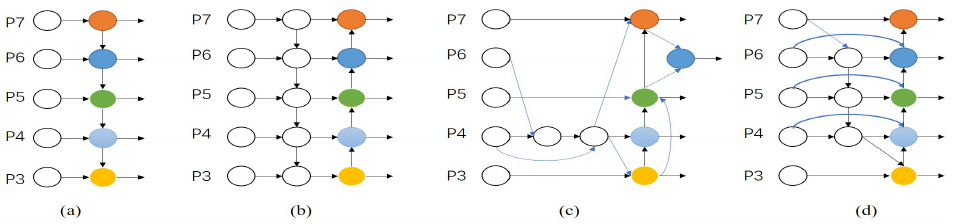
Figure 2. Feature network design. ( a ) FPN builds top-down networks with lateral connections to fuse detailed and semantic information (P3-P7); ( b ) PANET adds bottom-up paths to FPN to build a bidirectional fusion backbone network; ( c ) NAS-FPN uses neural architecture searching to find the most suitable feature network structure for the backbone network; ( d ) BiFPN, based on bidirectional scale linking, removes nodes with only one input edge and adds a residual structure to link the original junction and the output